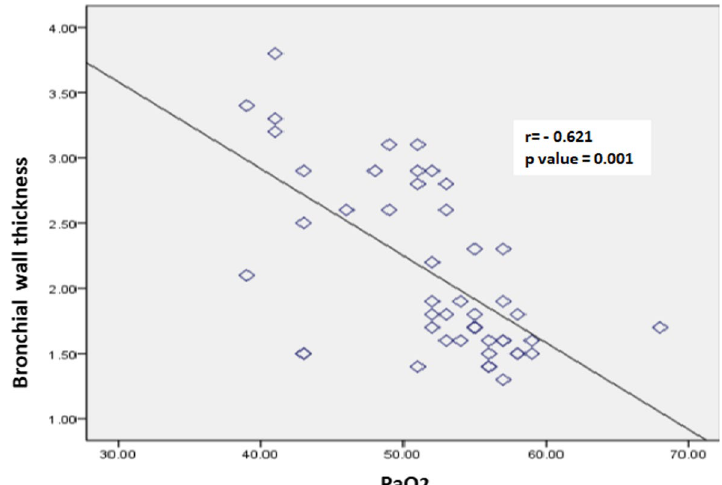
Fig. 4 Correlation between baseline PaO2 and bronchial wall